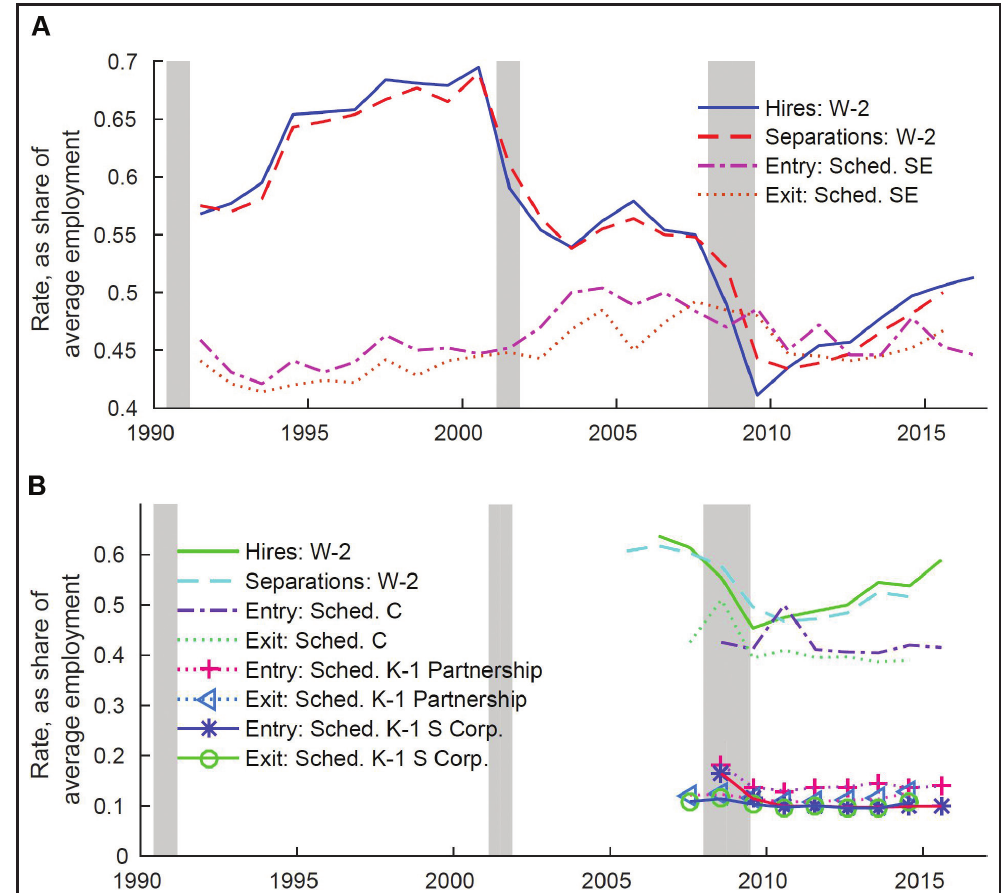
Figure 2 Hire and separation rates vs. BI entry and exit